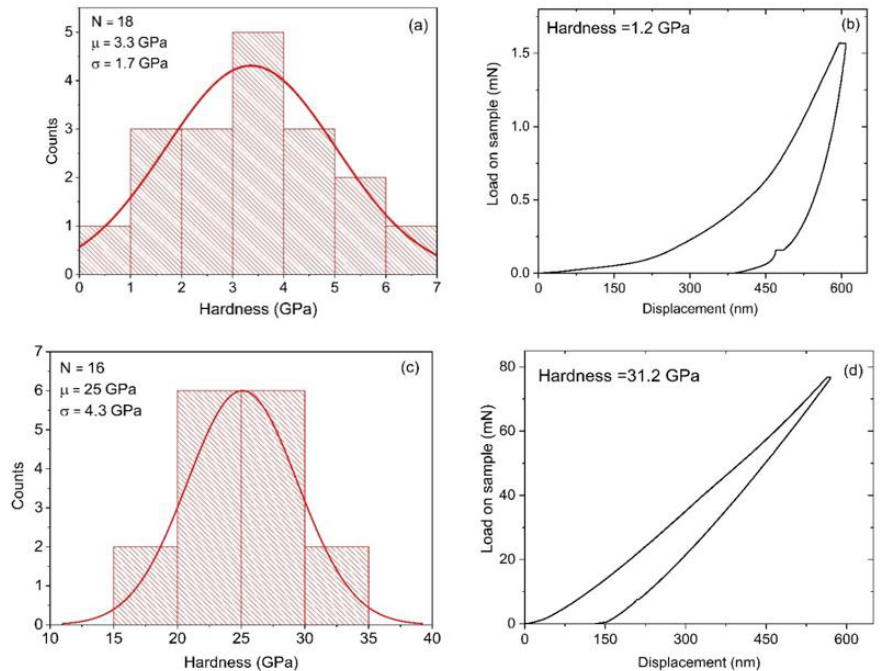
Figure 4. ( a ) Histogram from 16 indents showing hardness values for without-bias boron nitride coating. ( b ) Nanoinden- tation load/displacement curve from one location on the without-bias boron nitride coating at a depth of 600 nm. ( c ) His- togram from 16 indents showing hardness values for bias-enhanced boron nitride coating. ( d ) Nanoindentation load/dis- placement curve from one location on the bias-enhanced boron nitride coating at a depth of 600 nm. The extracted value of nano-indentation hardness 31.2 GPa is also indicated.